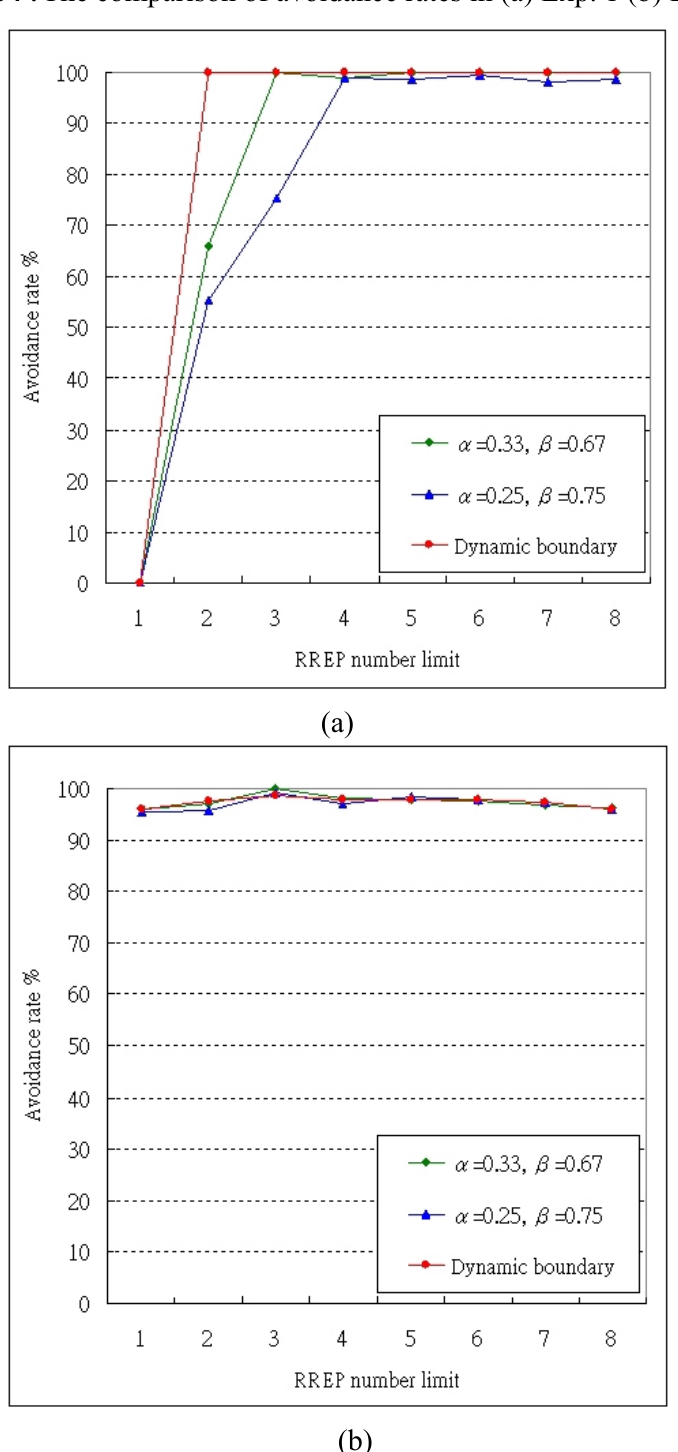
Figure 7. The comparison of avoidance rates in (a) Exp. 1 (b) Exp.